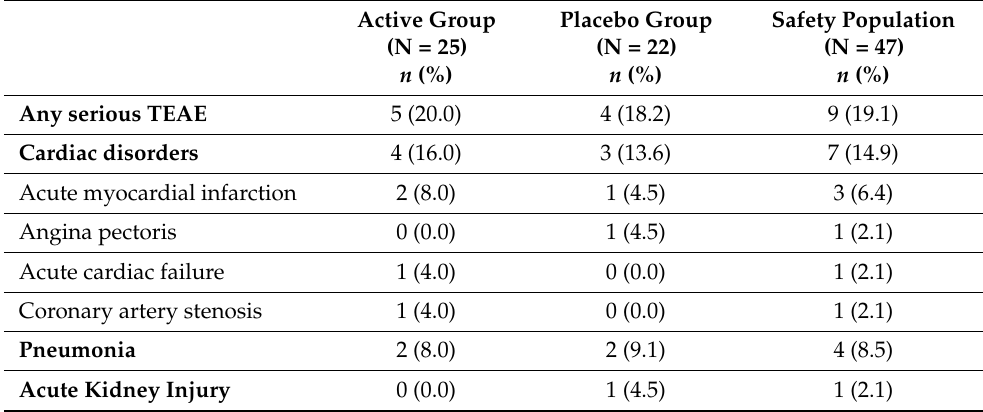
Table 3. Severe and Serious Treatment-Emergent Adverse Events (Safety